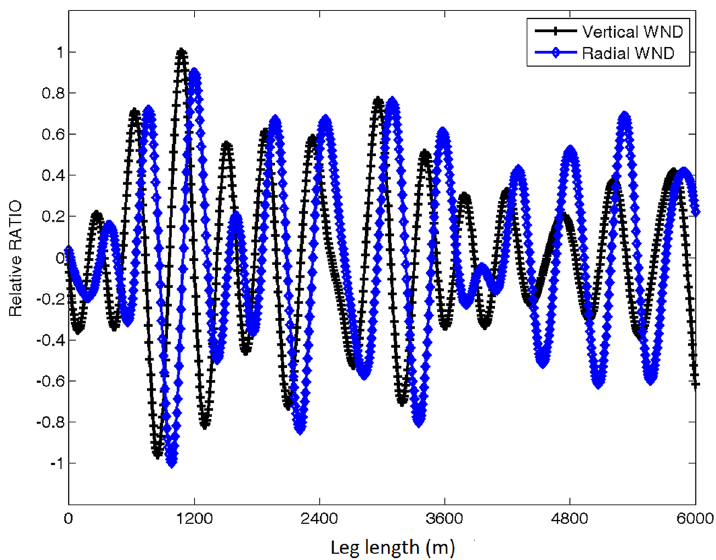
Figure 6. Plots of the vertical velocity normalized by the peak updraft (black) and radial wind velocity normalized by the maximum inflow strength (blue) for the roll leg in Typhoon Nida.